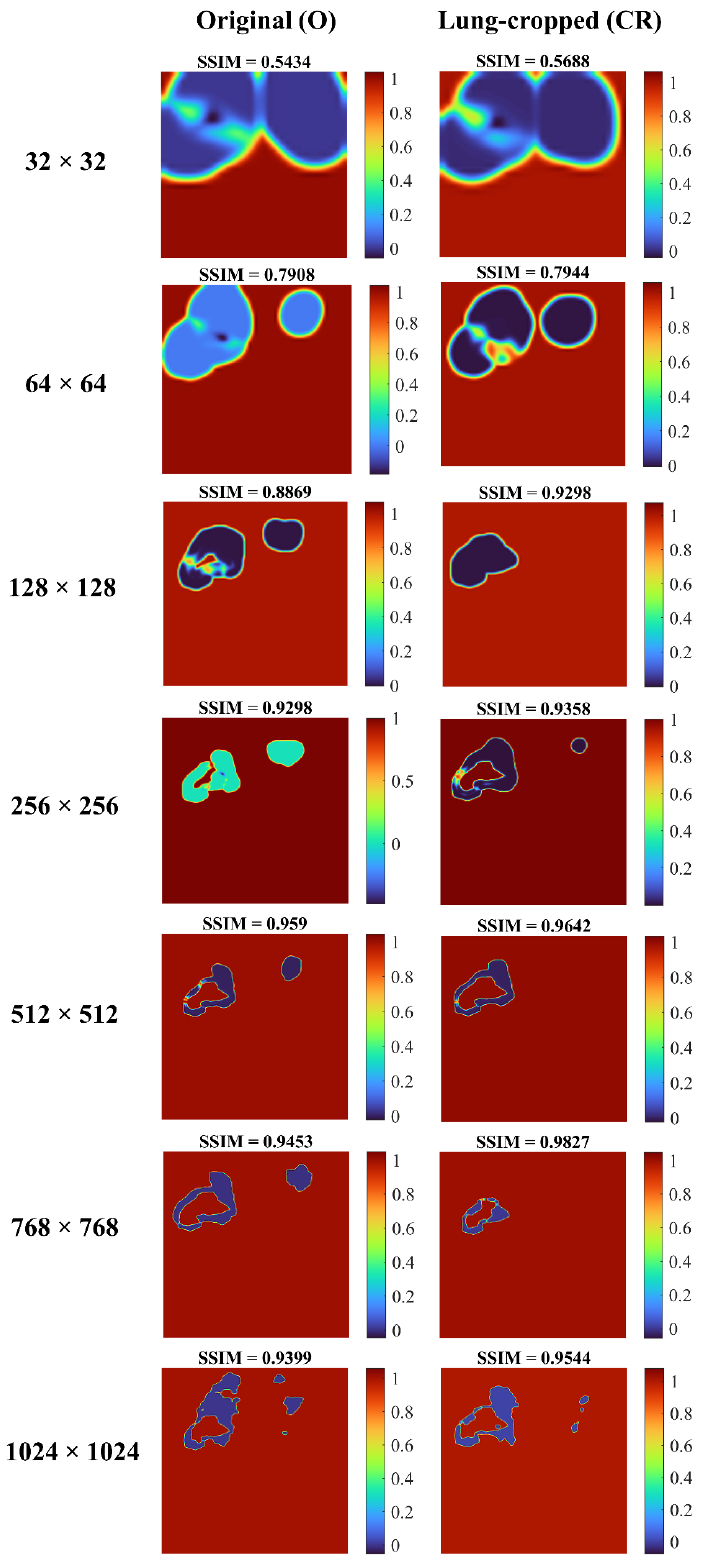
Figure 6. SSIM quality maps are shown for the predictions achieved by the Inception-V3 UNet model trained on various CXR/mask resolutions using a sample original and its corresponding lung-cropped data from the test set.